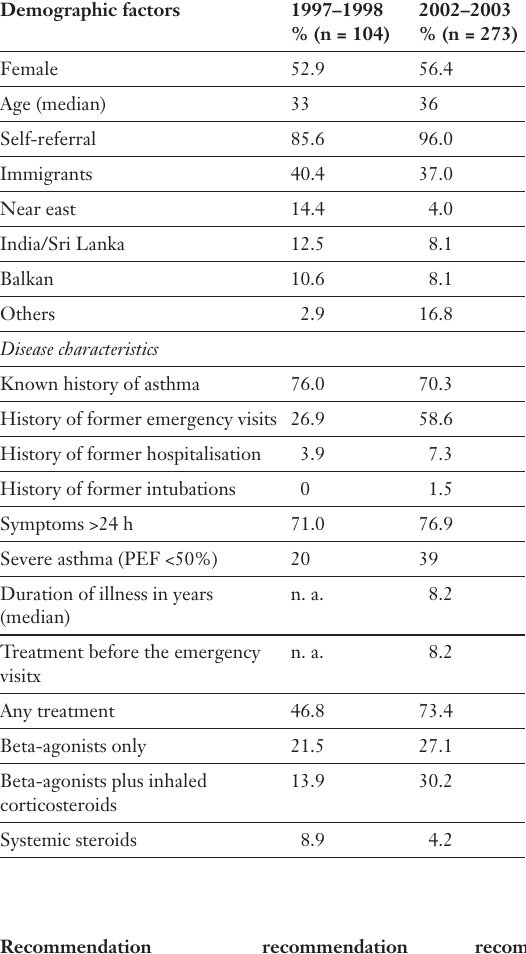
Comparison with adherence to guide- line recommenda- tions before and after using a management protocol.